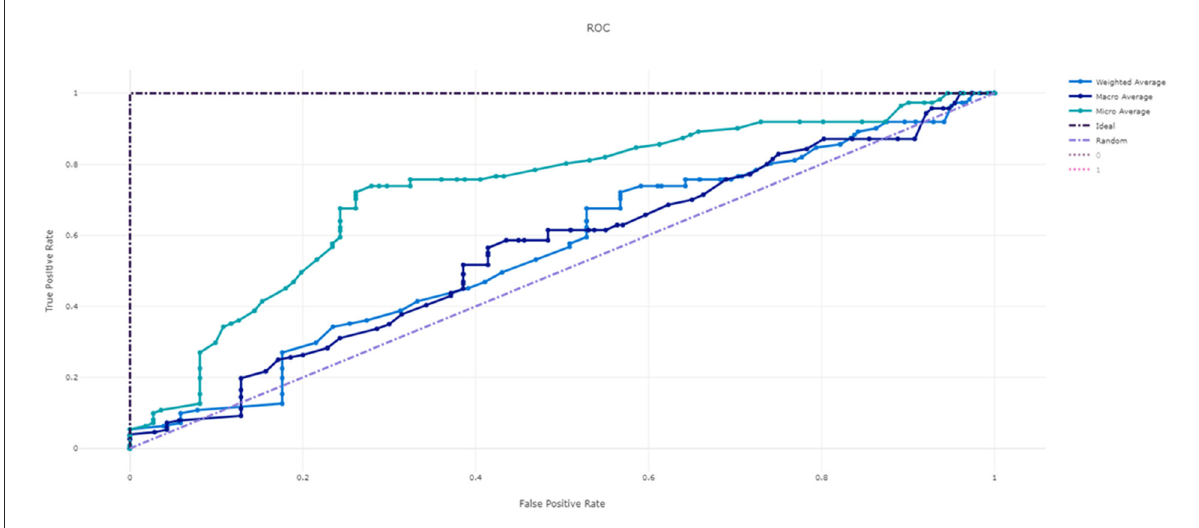
FIGURE3 ROC curve of XGBoost model predicting fall risk among hospitalized elderly.